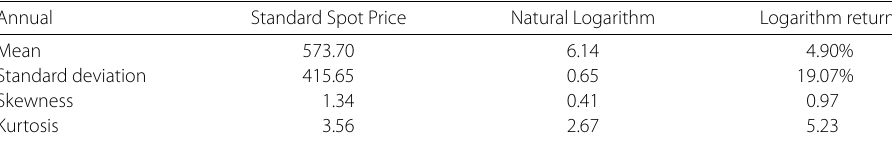
Table 2 Descriptive statistics of the annual gold spot price, its natural logarithm, and its logarithm returns. Source: Data from Bloomberg XAUUSD Annual Standard Spot Price Natural Logarithm Logarithm return Mean